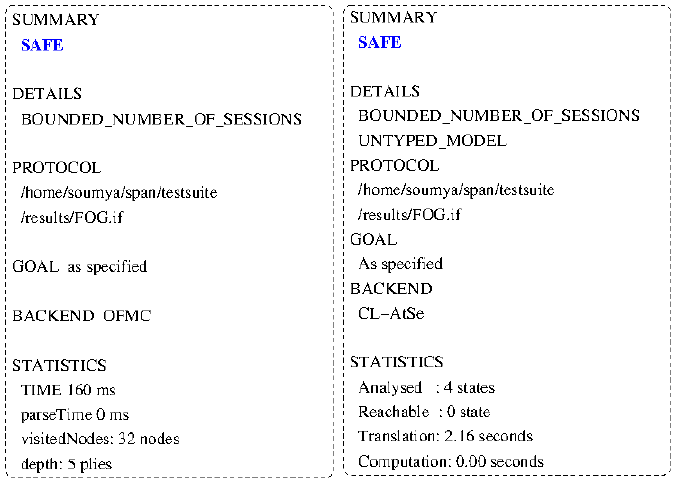
Figure 11. Results of AVISPA simulation under OFMC and CL-AtSe backends.